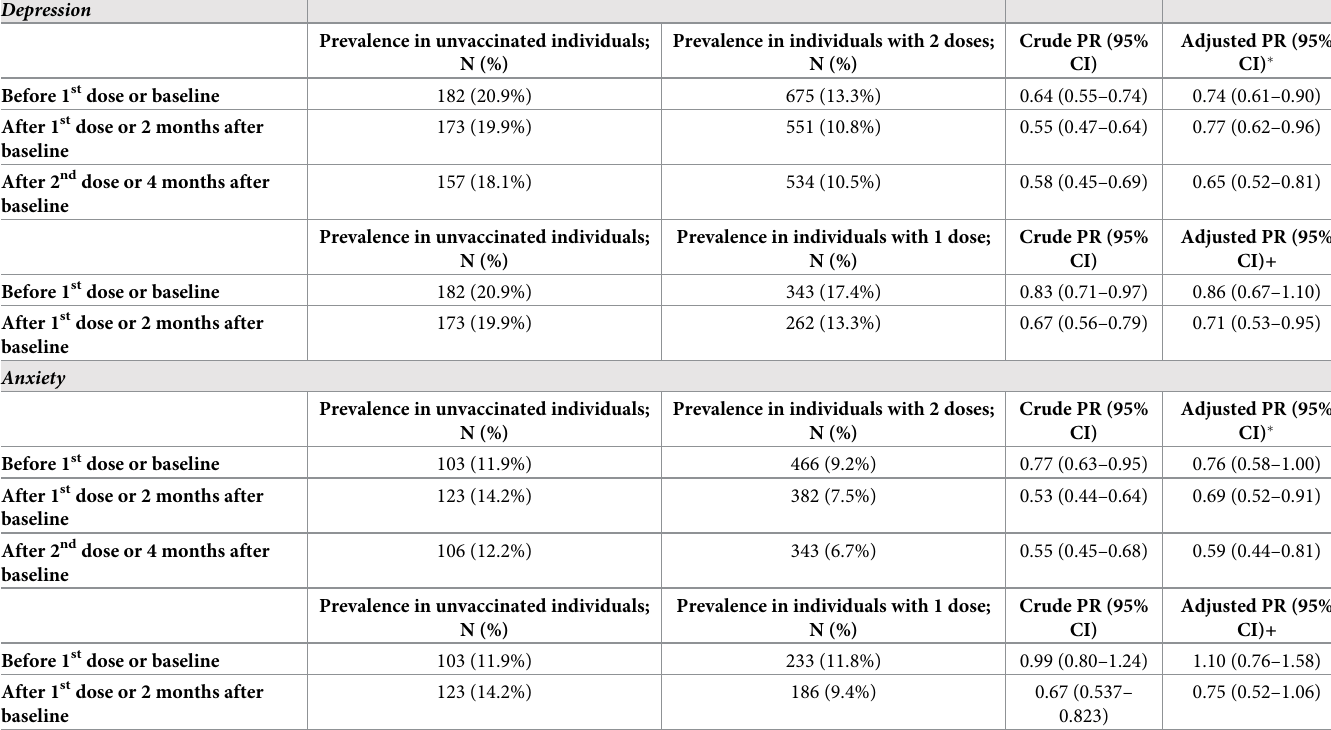
Table 2. Prevalence ratio (PR) and 95% confidence interval (CI) of self-reported depressive and anxiety symptoms comparing vaccinated to unvaccinated individuals. Depression